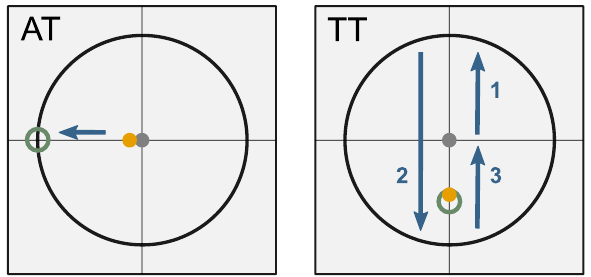
Figure 3. Description of the aiming task (AT) on the left and the tracking task (TT) on the right. The yellow dot displays the cursor controlled by the participants. The gray dot displays the starting point in the middle of the coordinate axes. The green circle is the respective target. During the AT, a target located along the cardinal axis had to be reached as quickly and accurately as possible. During the TT, participants had to track the target which moved with constant velocity along the horizontal or vertical